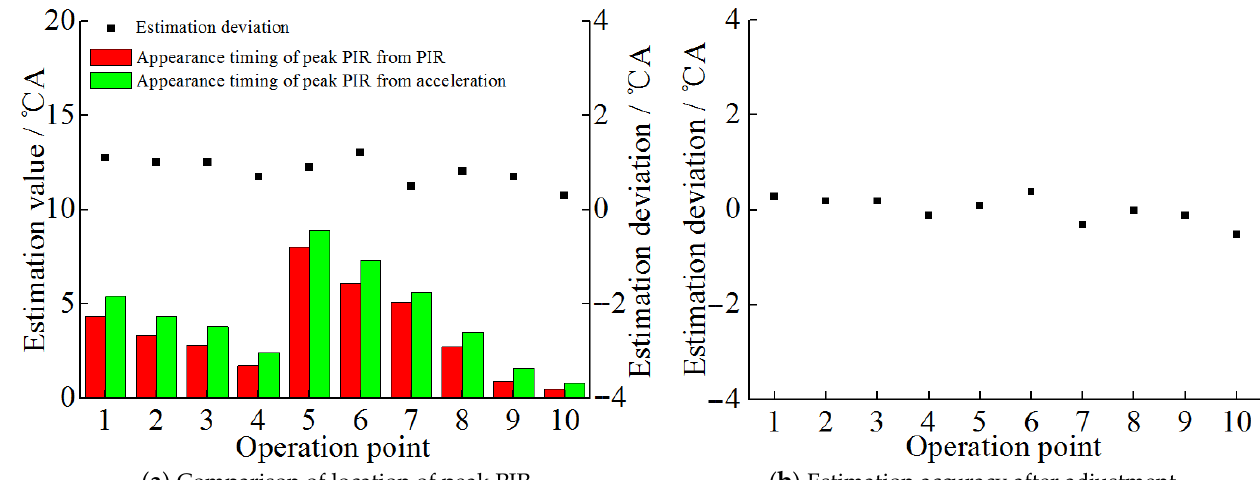
Figure 15. Accuracy comparison of location of peak PIR.